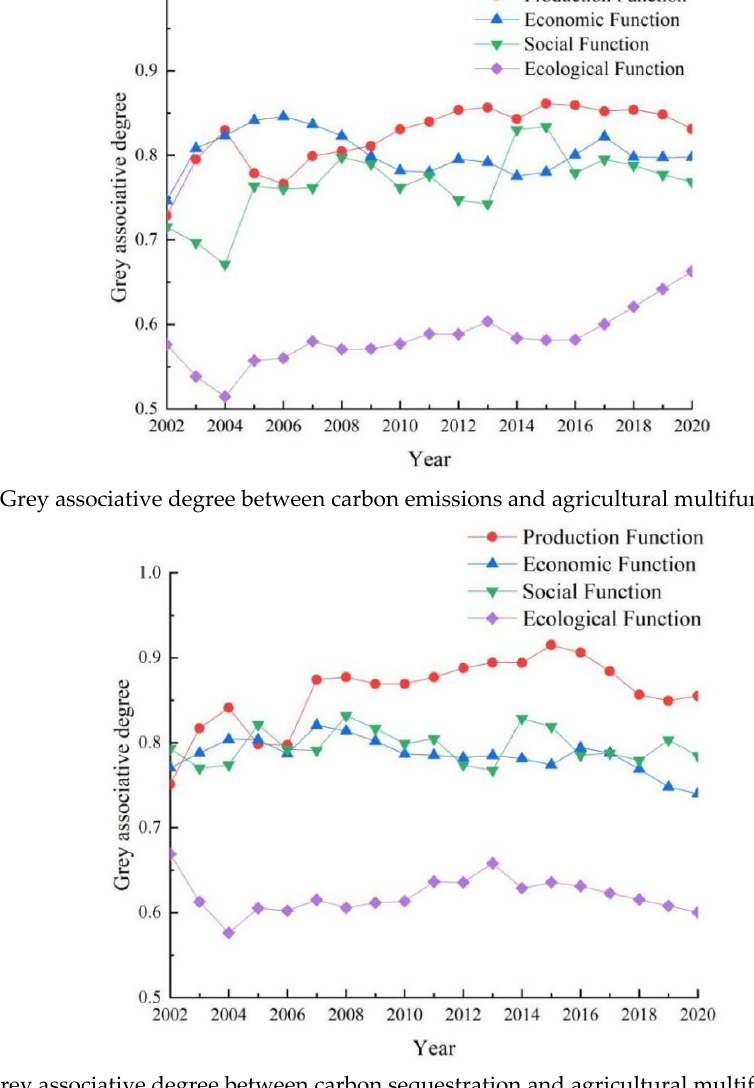
Figure 10. Grey associative degree between agricultural multifunctionality and carbon emissions as well as carbon sequestration from 2002 to 2020.